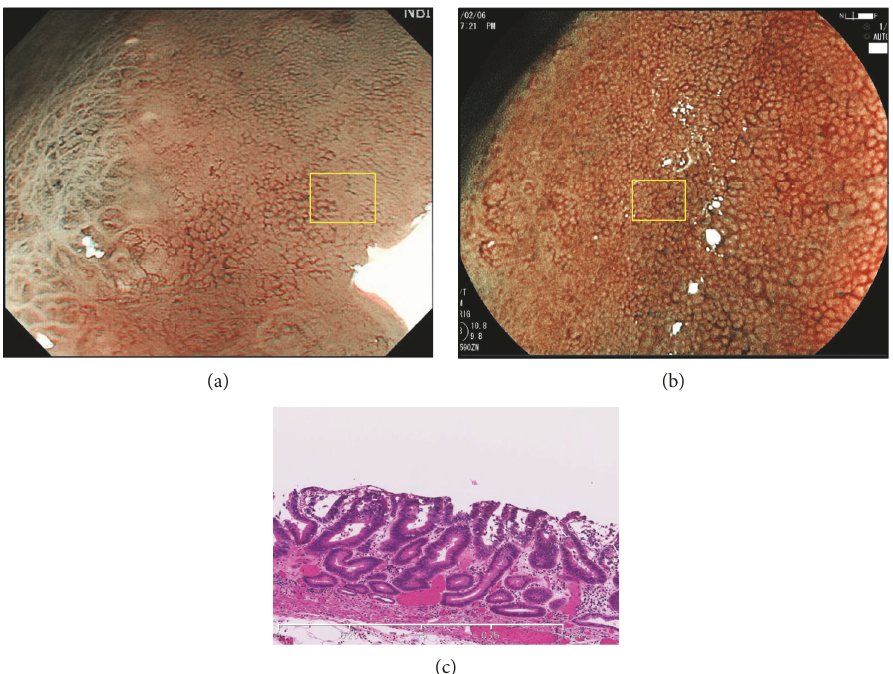
Figure 2: A well-di ff erentiated adenocarcinoma in group A. (a) MSP was absent on ME-NBI (yellow box). (b) ME-BLI showed an irregular MSP (yellow box). (c) Histological view of the yellow box in Figures 2(a) and 2(b). The crypts were very shallow.